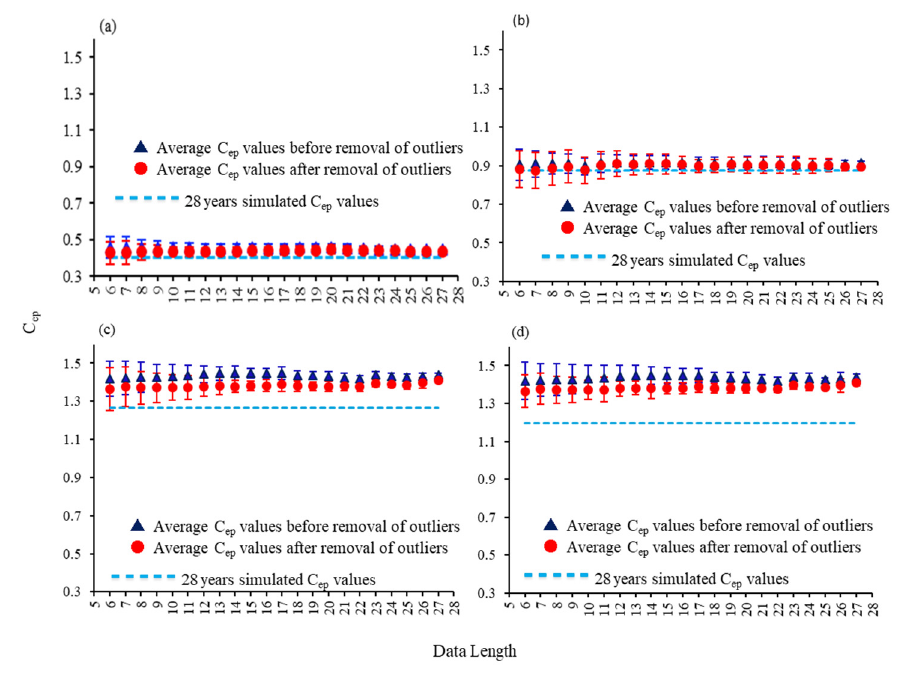
Figure 9. Comparison of C ep values in subsets before and after the removal of outliers in ( a ) Doki